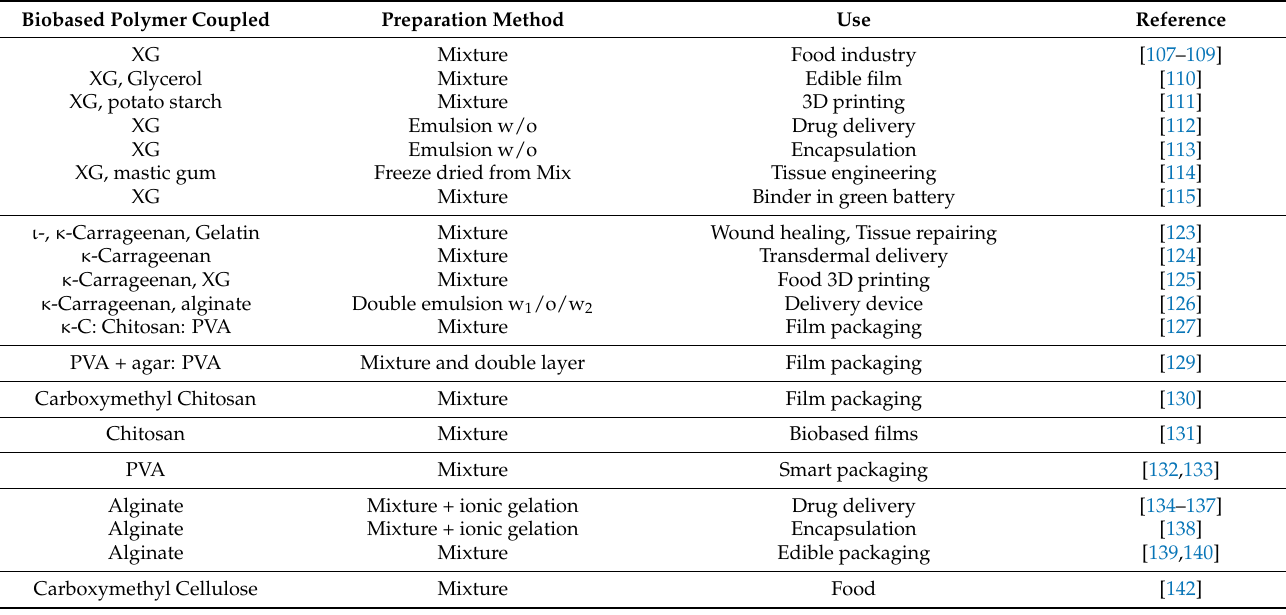
Table 1. Examples of synergies between LBG and other biobased polymers, method of preparation of the mixtures and their